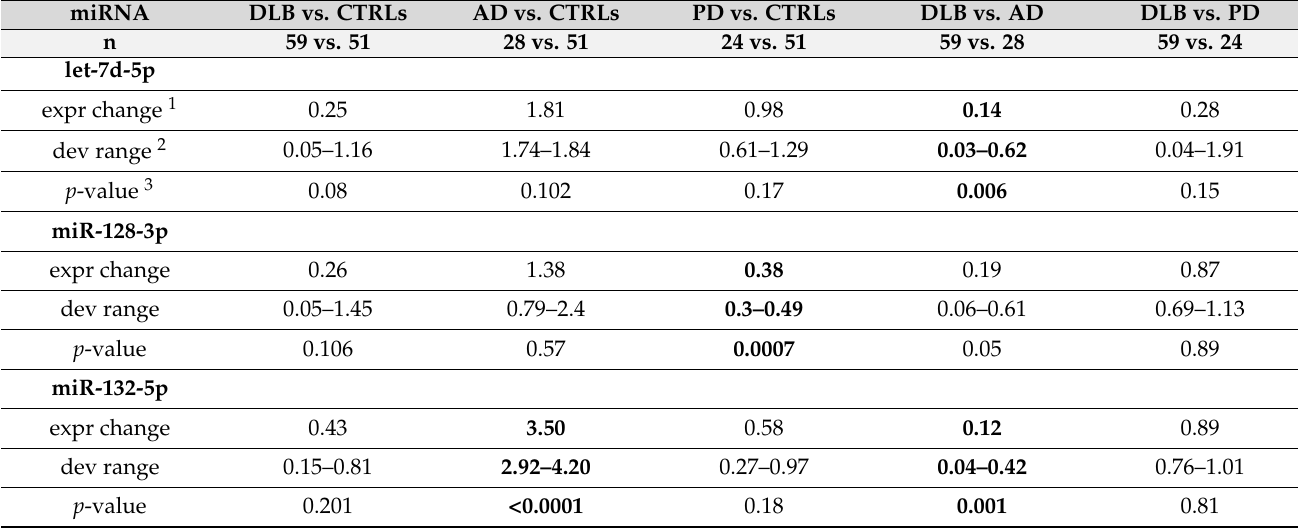
Table 4. Combined results of Studies